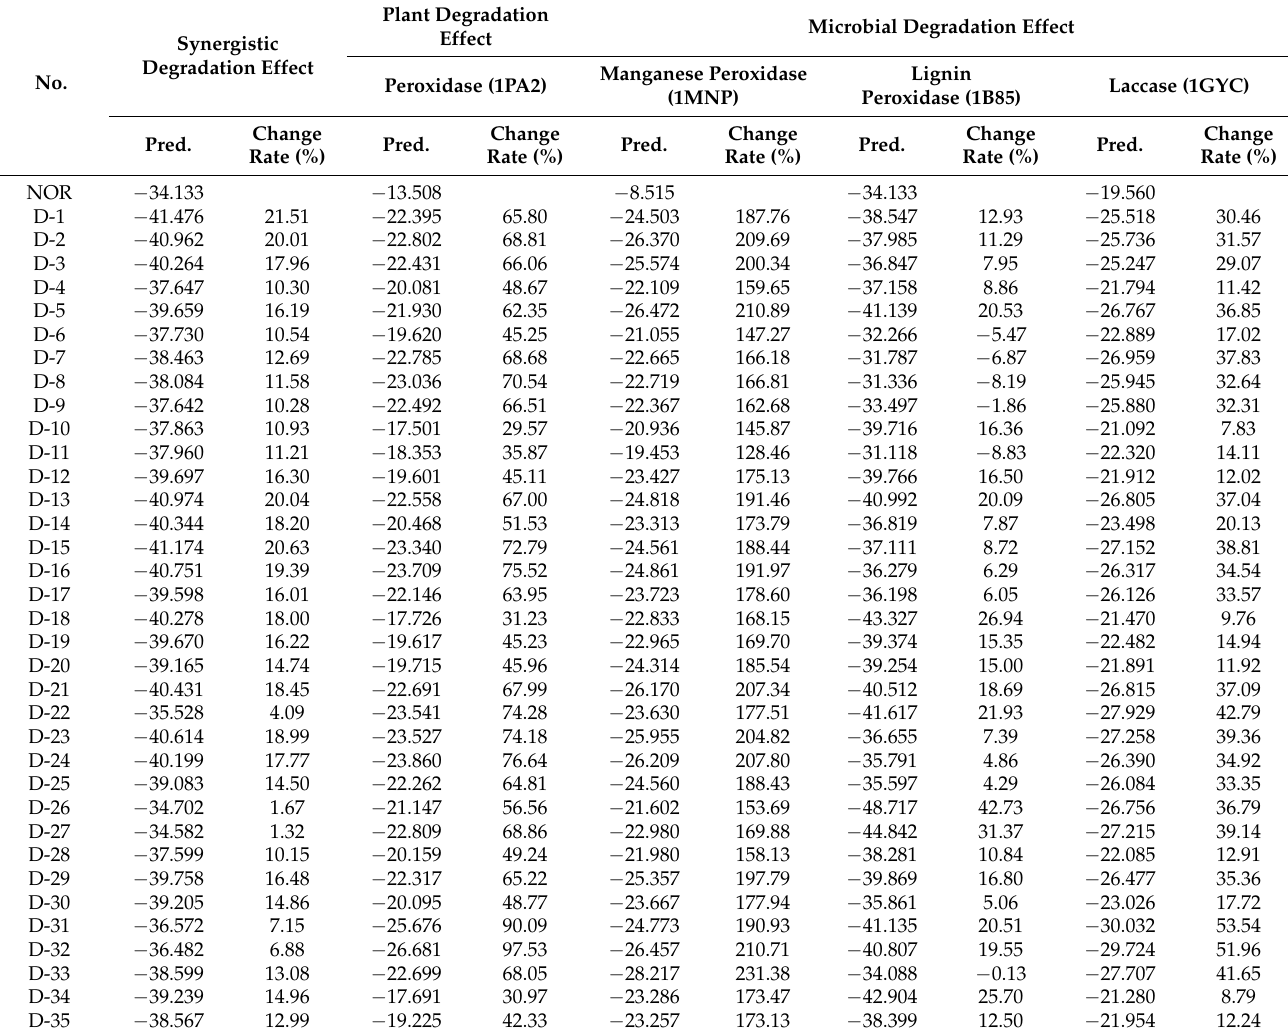
Table 4. The values and change rates of the plant, microbial, and plant–microbial synergistic degradation effects of NOR and its derivatives predicted using the CoMSIA